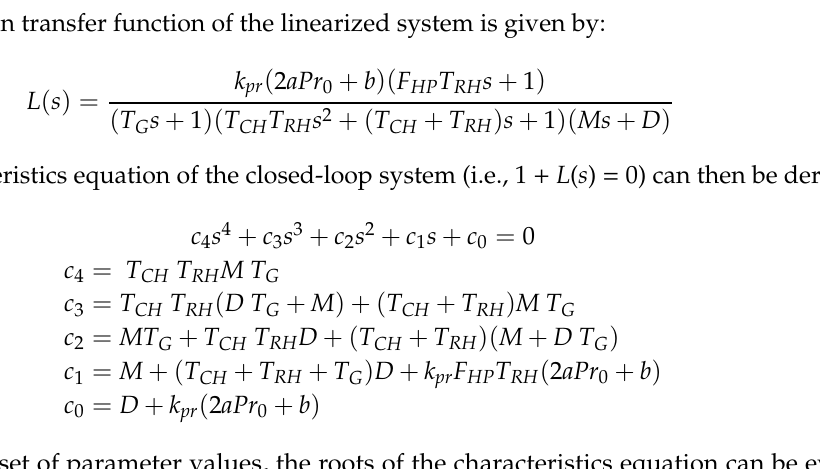
Figure 4. Linearized transactive frequency droop control loop diagram.